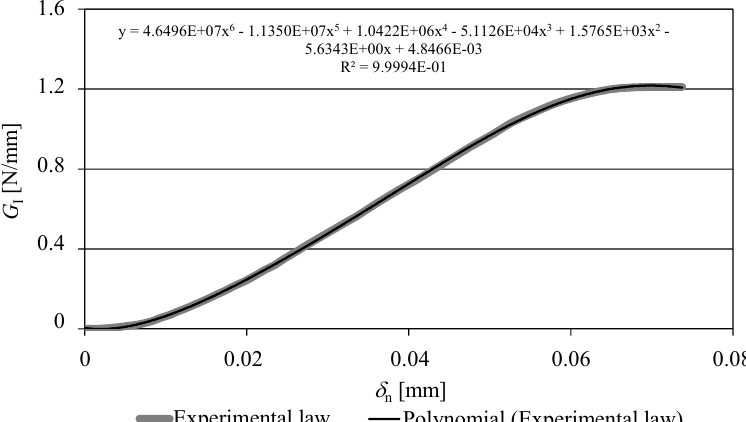
Figure 9: Experimental G n -  n law for one test specimen with h =3 mm and polynomial fitting curve (configuration 2).